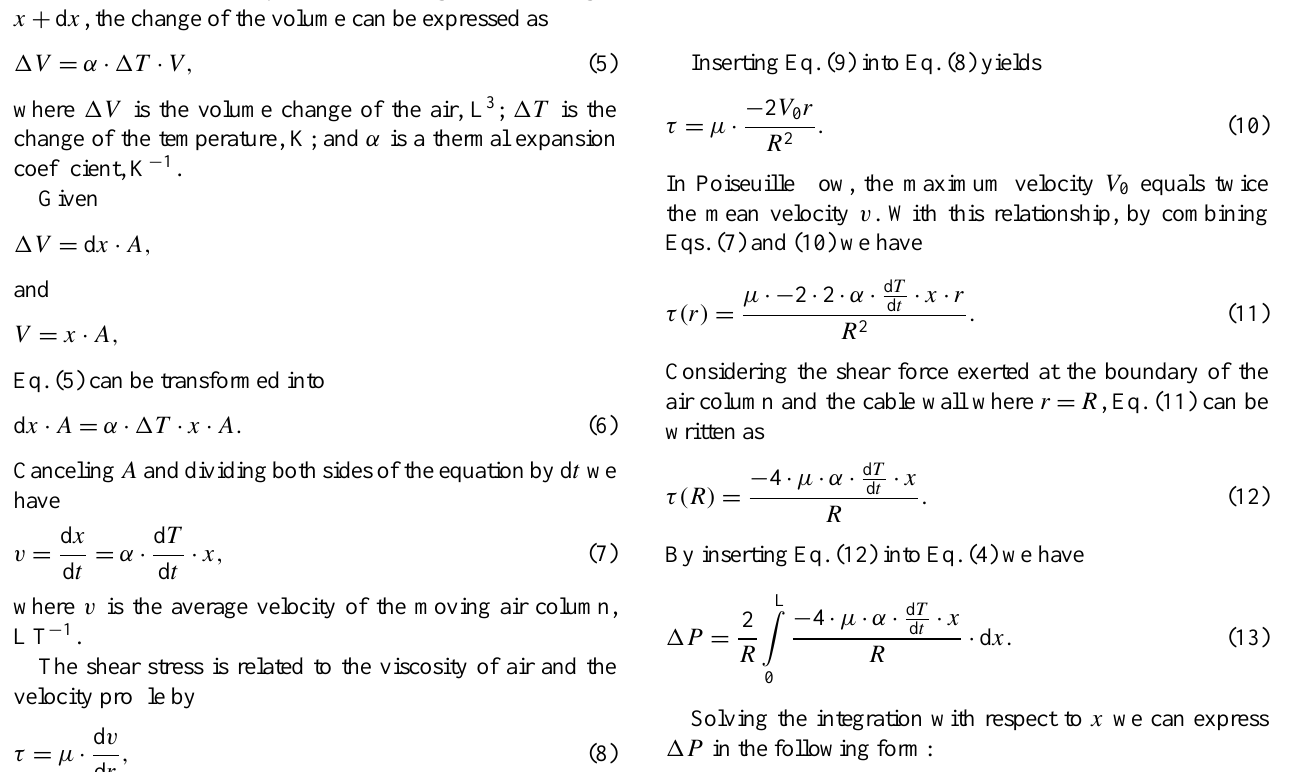
Figure 5. Errors in water level measurement associated with tem- perature gradient and absolute temperature. The temperature gradi- ent was calculated over a 10min